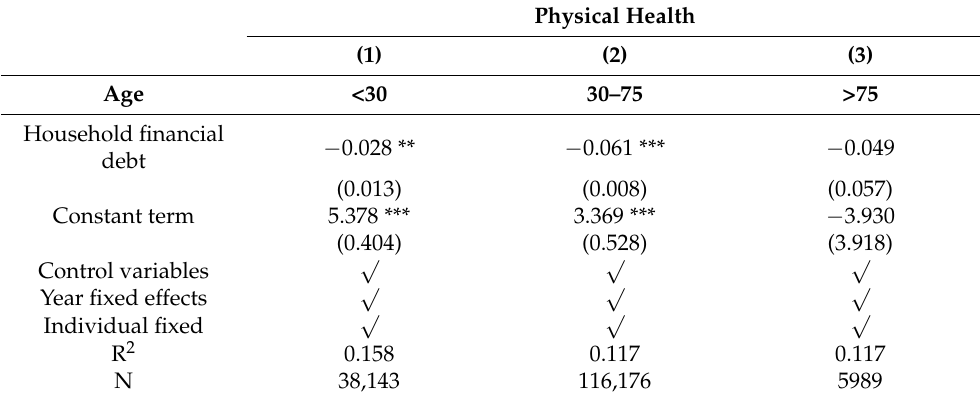
Table 7. Regression results of age heterogeneity.